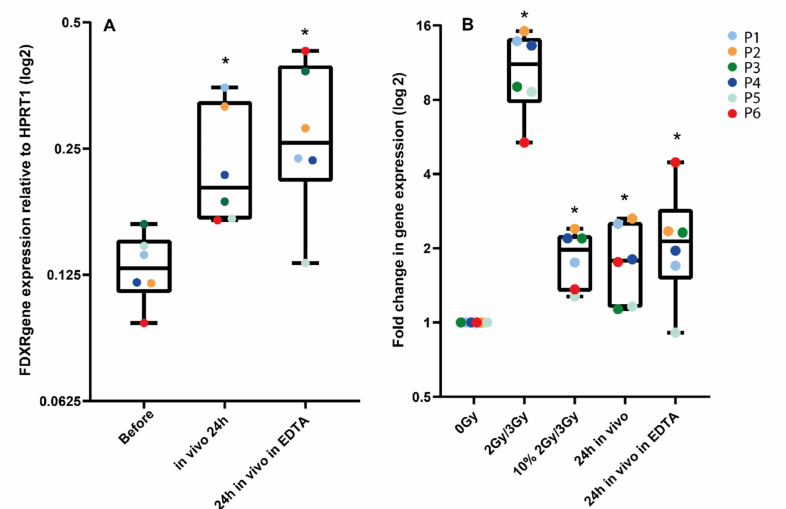
Figure 4. Comparison of FDXR transcriptional response to radiation in vivo and ex vivo from the same donor. In panel A , 24 h post-exposure samples taken directly into PaxGene tubes were compared to samples taken in EDTA tubes left at room temperature for 2 h, then in a PaxGene tube for storage to mimic the ex vivo sample manipulation. In panel B , blood collected from each patient before radiotherapy was exposed ex vivo to 2 Gy or 3 Gy, depending on the patient-specific radiotherapy schedule. These samples were compared to a diluted ex vivo exposed sample (i.e., 10% in non- irradiated blood) and to in vivo samples 24 h after exposure in PaxGene tubes or EDTA/PaxGene tubes. * Significantly different from the control (before treatment or 0 Gy) (paired t test, p ≤